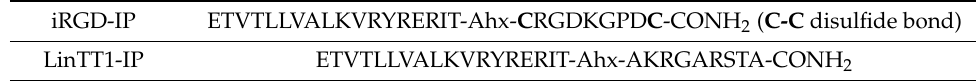
Table 1. Sequences considered for experimental